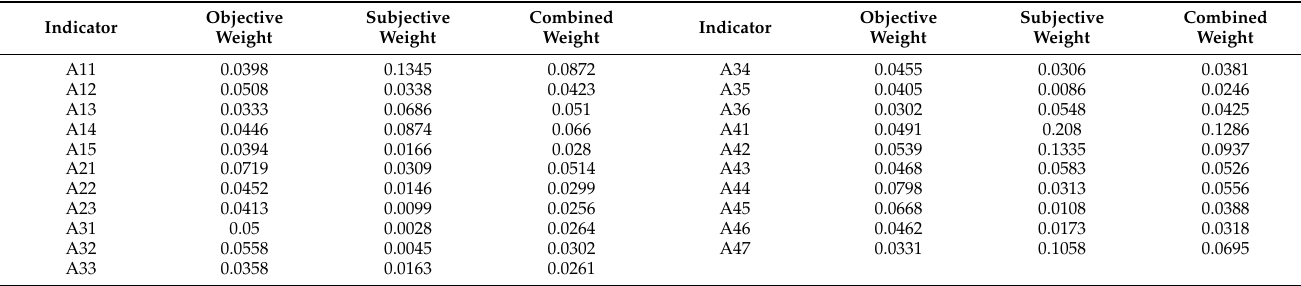
Table 3. The evaluation indicator weight of safety culture among residents during COVID-19